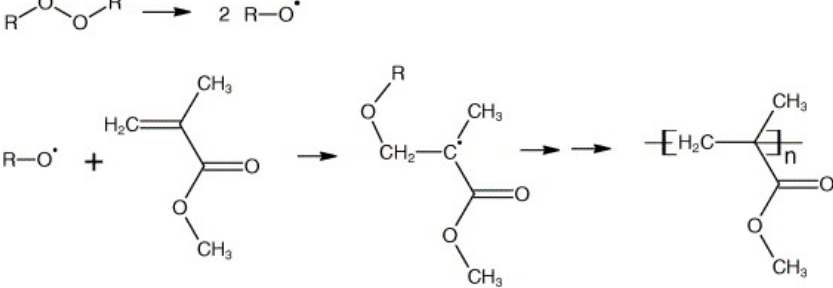
Figure 1. Free radical vinyl polymerization of methyl methacrylate (MMA) to poly methyl methacrylate (PMMA) with dibenzoyl peroxide initiator [11,12].